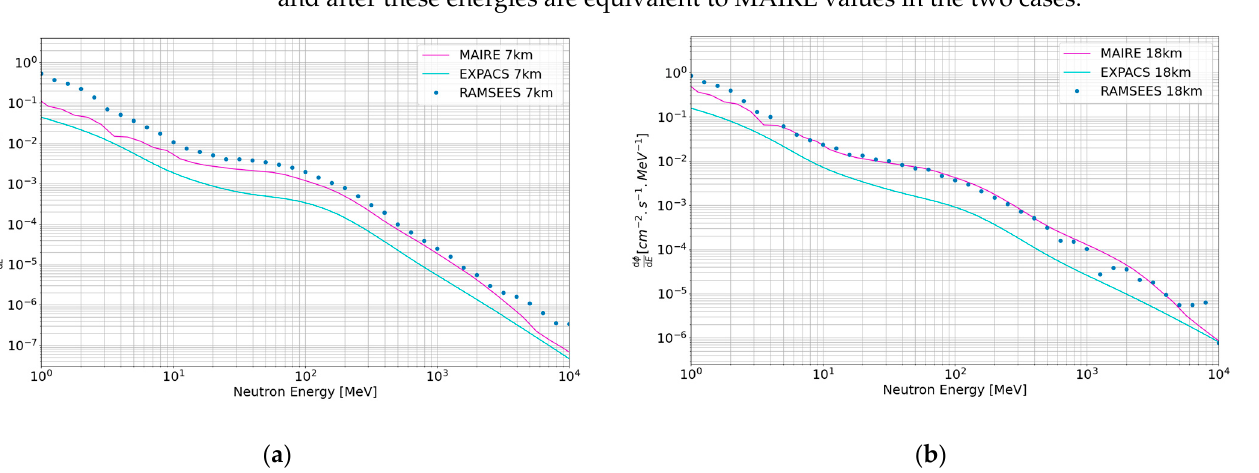
Figure 15. RAMSEES spectrum of secondary neutrons at several altitudes compared to standard and to the models MAIRE & EXPACS: ( a ) ground level compared to JEDEC; ( b ) 12 km of altitude compared to IEC.